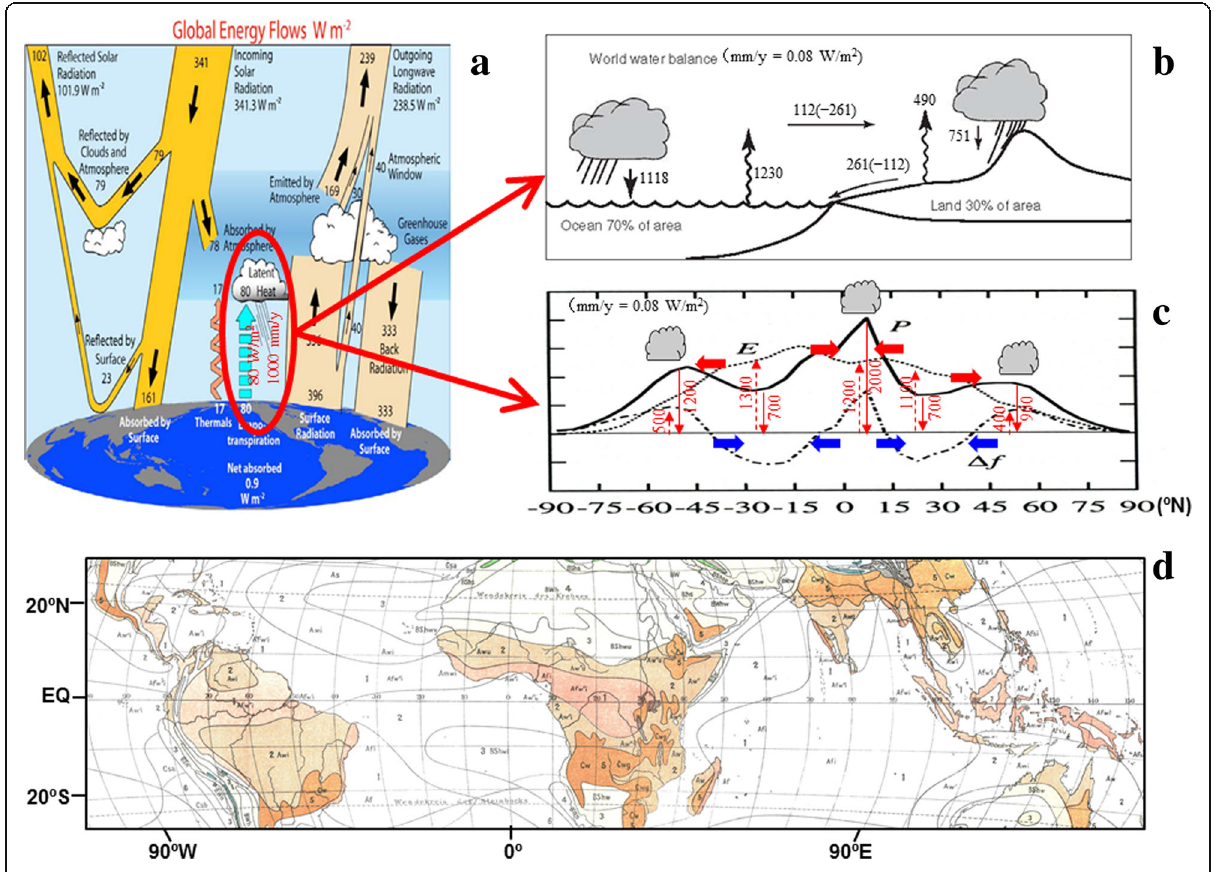
Fig. 1 a The global energy and water cycle (modified from Trenberth et al. 2009) and its alternative distributions: b in sea and land (modified from Hartmann 1994, with values according to Trenberth et al. 2009) and c in latitude (modified from Hartmann 1994, which was based on Baumgartner and Reichel 1975; originally much older, at latest up to Meinardus ’ analysis published in 1934; see Jaeger 1983). d Low-latitude part of Köppen ’ s (1918) original climate classification map showing already both latitudinal and coastal